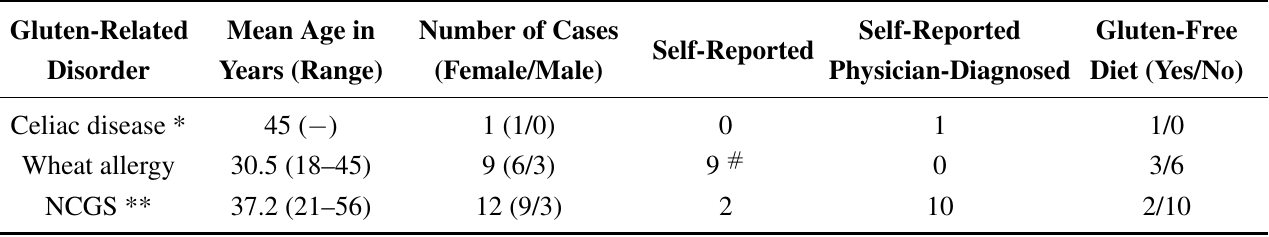
Table 2. Characteristics of identified self-reported gluten-related disorder